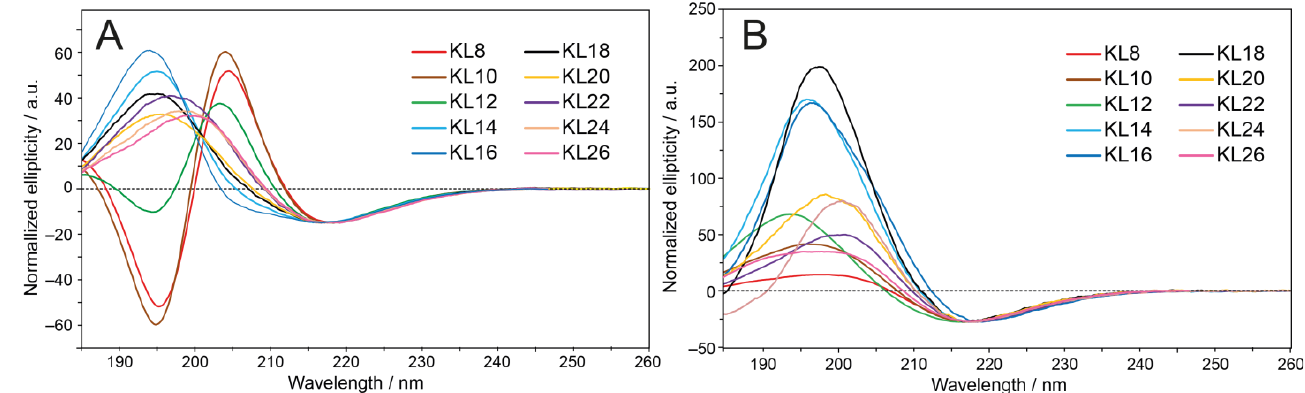
Figure 3. Oriented CD (OCD) spectra of KL peptides with an even number of residues. The P/L of KL14 was 1/20, and the same mass ratio was used for the other peptides. Spectra are normalized to the intensity of KL14 at 217 nm. ( A ) In POPC/POPG (1/1), all peptides show a minimum close to 217 nm, indicating extended β -strands or complete β -sheet formation. The shortest peptides KL8, KL10 and KL12 also have another minimum at approximately 195 nm, suggesting a partially unstructured conformation. ( B ) In DMPC/lyso-MPC (2/1), all peptides show a minimum at 217 nm and very broad positive bands, indicating β -sheet formation, given, for the longer peptides, strong absorption flattening artifacts due to aggregation.